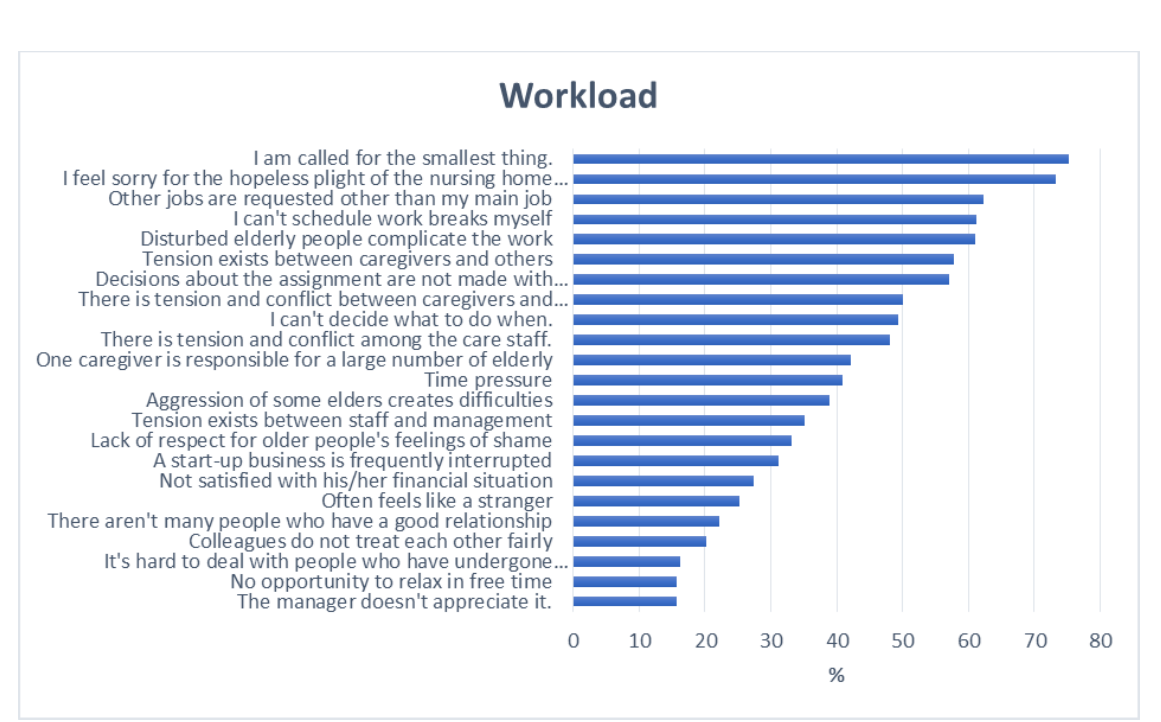
Figure 1. Participants’ answers regarding workload, as percentages ( n = 154).